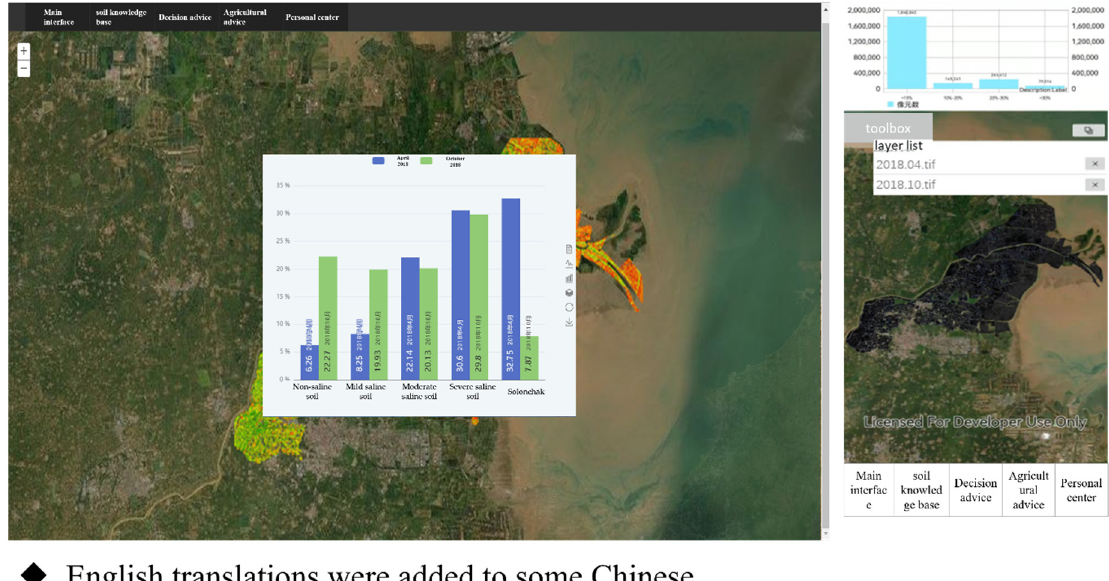
Figure 7. Analysis of the spatial and temporal variation of soil salinity in the Kenli area of the Yellow River Delta. Table 4. Spatial-temporal variation of salinization in Kenli District, Yellow River Delta in 2018.